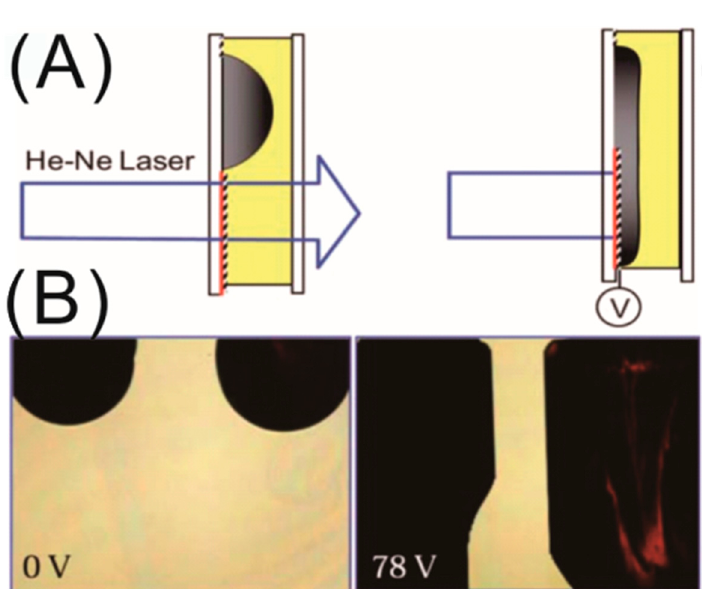
Figure 6. ( A ) Schematic representation of the working principle of the optical switch based on dielectrowetting spreading of liquid drop. ( B ) Liquid crystal droplet-based optical switches in the off and on (78 V) state. The left droplet shows a black color and the right one shows red. Images are reproduced from Reference [66] with permission of the Royal Society of Chemistry.